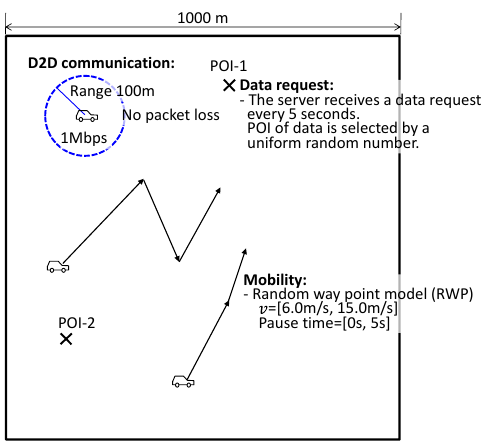
Figure 15. Simulation model for vehicle case (communication and mobility).